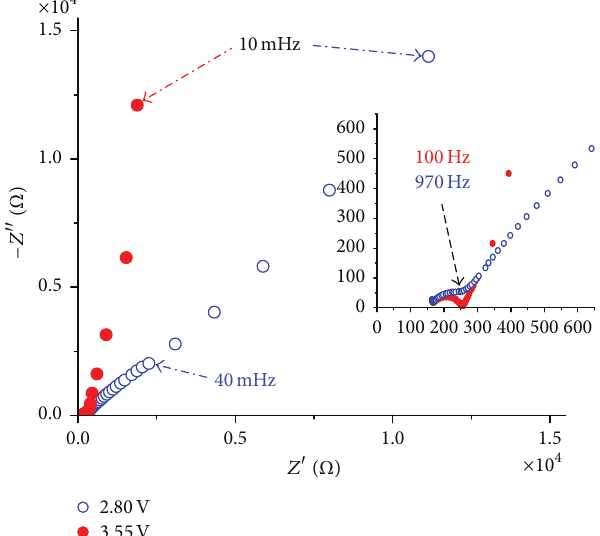
Figure 12: Electrochemical impedance spectra of NiO 𝑥 sintered via CS at different applied potentials (2.8 and 3.55 V versus Li + /Li) when film thickness is 𝑙 = 0.3 𝜇 m. In the larger picture 40 mHz marks the onset of the diffusive regime in NiO 𝑥 when polarized at 2.8 V. In the inset the specified frequencies refer to the point of closure of the high-frequency semicircles. For cell configuration and electrolyte used, see Figure 1.